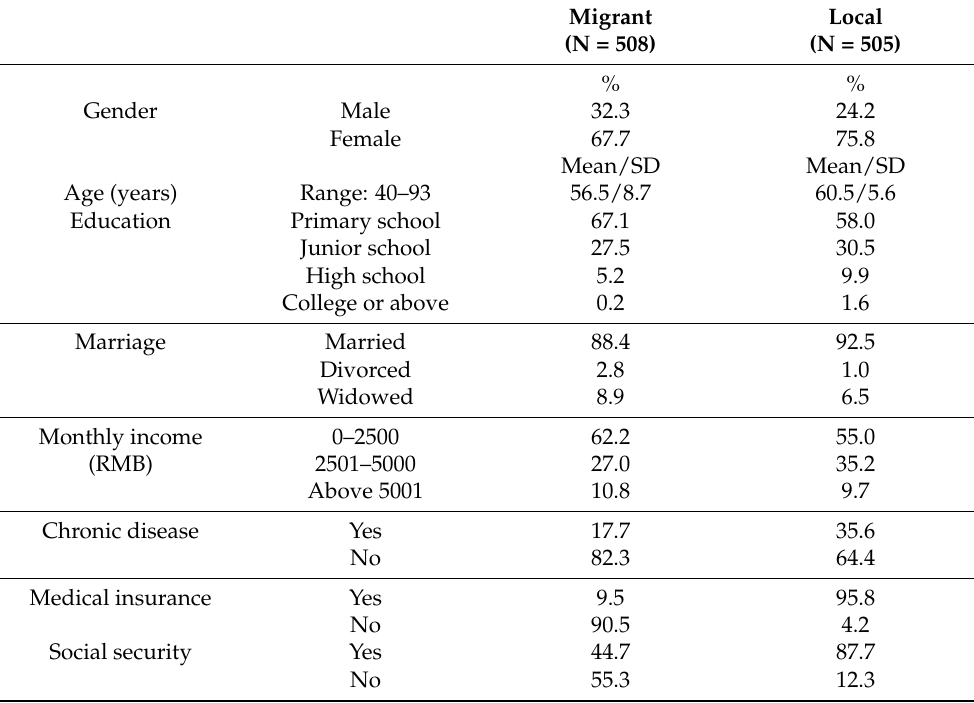
Table 1. Demographic information of participants (N =